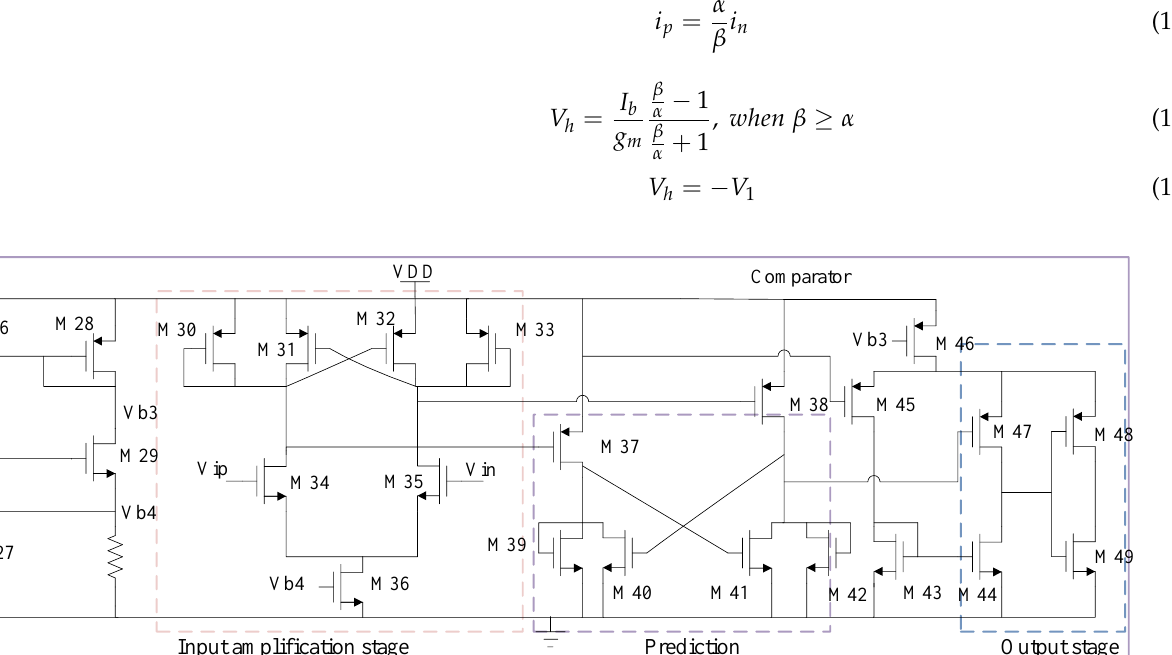
Figure 9. Circuit diagram of the hysteresis comparator.